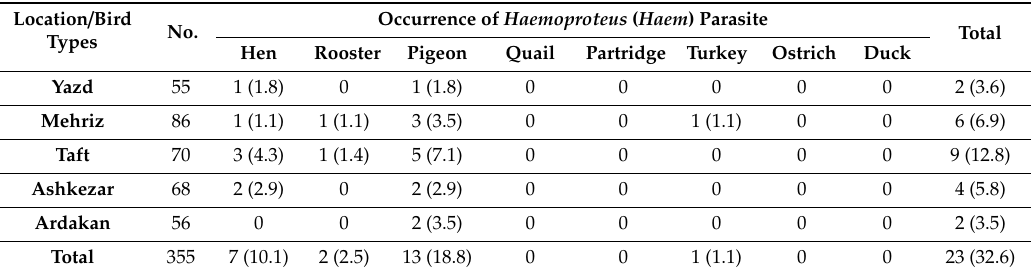
Table 1. Occurrence of Haemoproteus (Haem) parasite in eight species of birds located at five counties in Yazd province, central Iran.